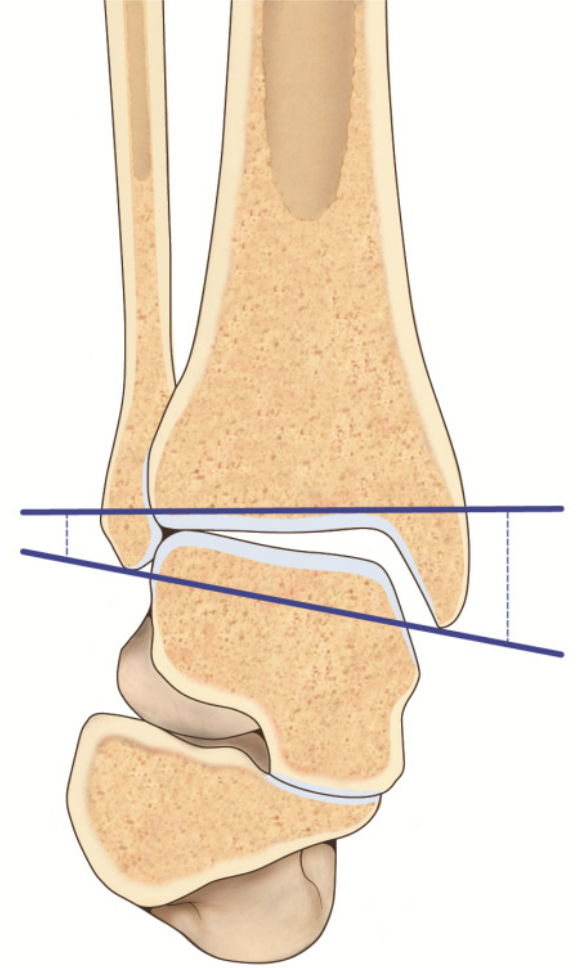
Figure 3. Visual artwork highlighting the bimalleolar angle.